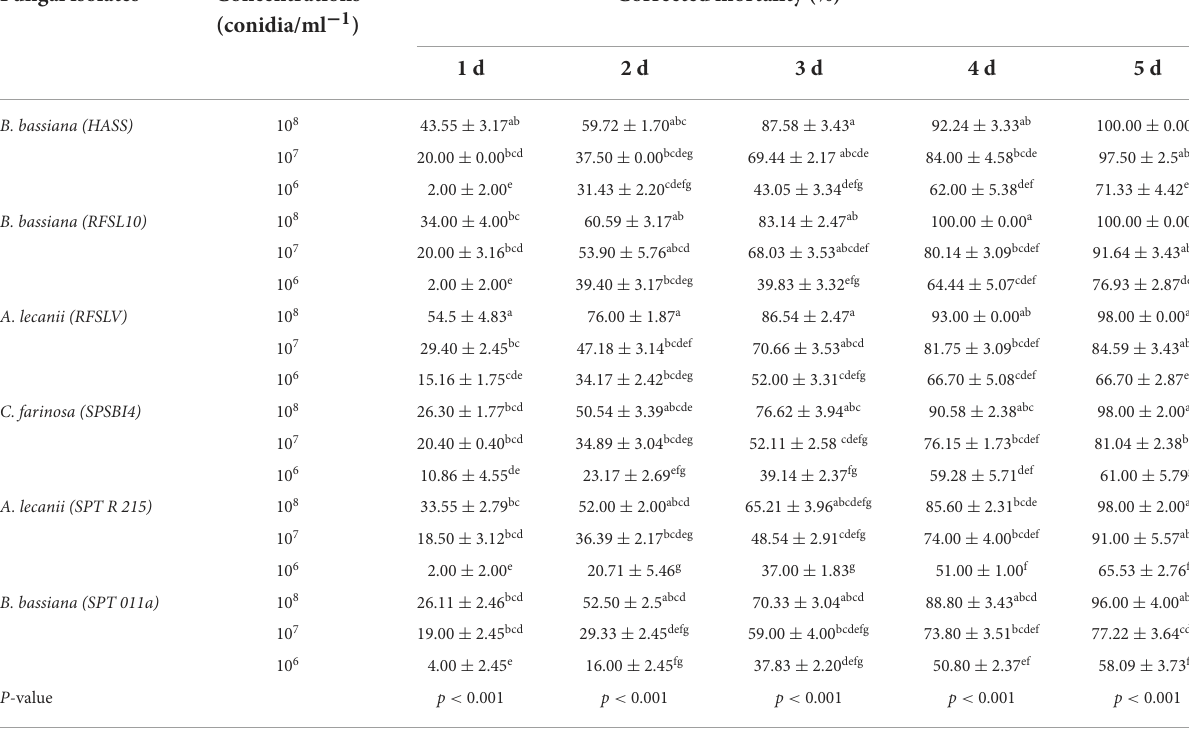
TABLE 3 Mean percentage of D. opuntiae nymphs mortality after exposure to different entomopathogenic fungi isolates at 3 concentrations. Fungal isolates